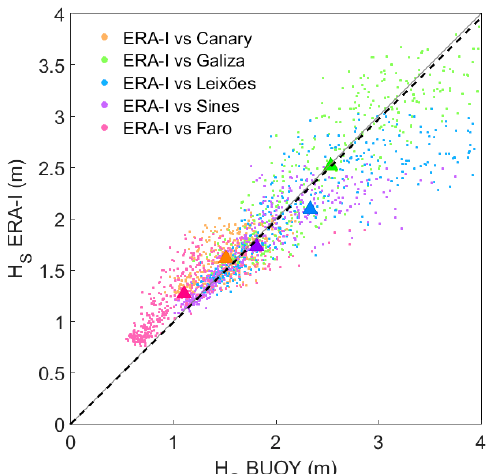
Figure 2. Scatterplot of daily mean in situ measured versus ERA-Interim H s from the five buoys in Figure 1. Each dot in the background corresponds to a daily mean comparison. The linear fit (black dashed line) has been computed for the total dispersion from the five buoys. The triangles correspond to the full means.